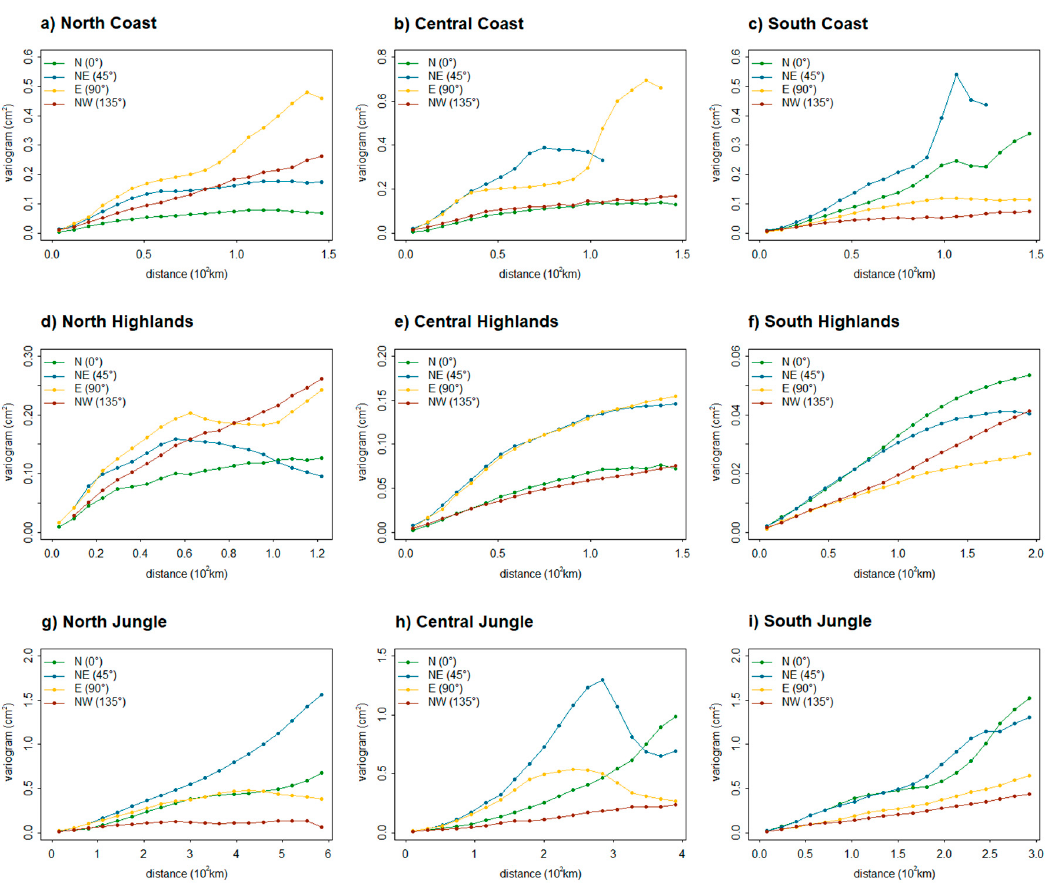
Figure 3. Same as Figure 2, for the JJA